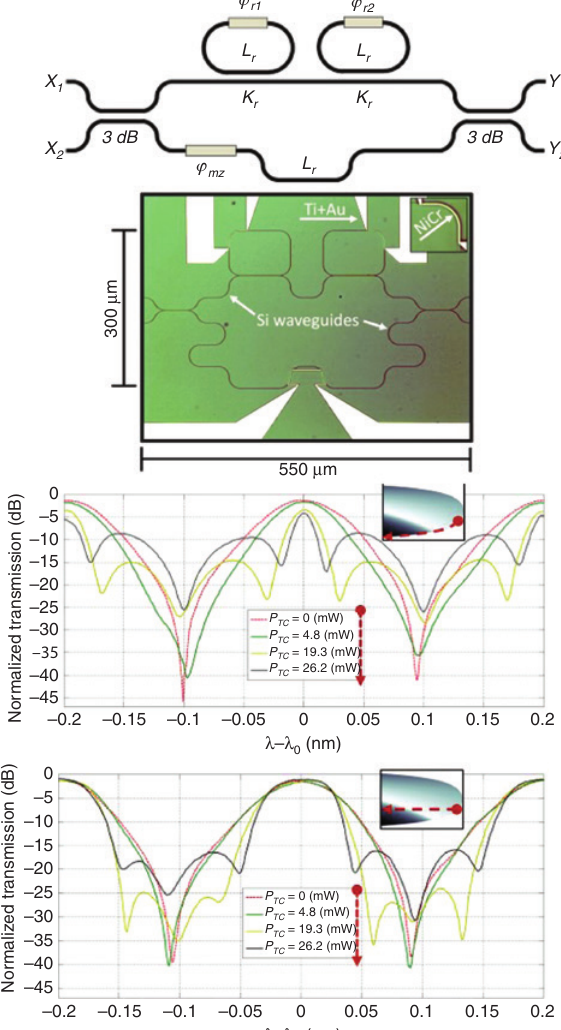
Figure 23: A bandwidth tunable filter in silicon [100] (Copyright in 2014,